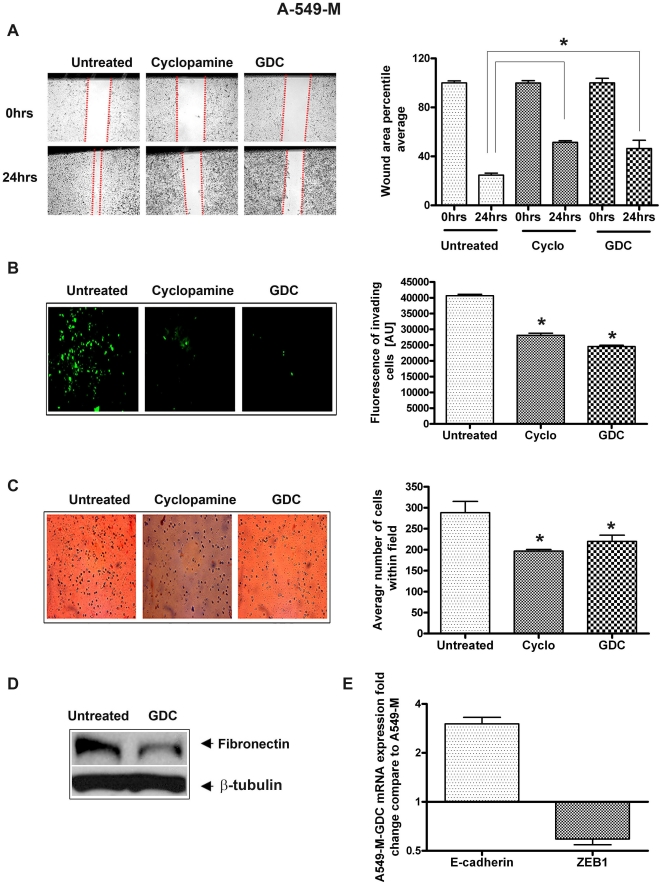
Up-regulation of Shh in A549-M cells contributes to increased tumor cells migration and metastatic characteristics:A549-M cells were treated with Shh inhibitors such as Cyclopamine (2 µM) and GDC-0449 (20 nM) and assayed for wound healing (A), invasion (B) and clonogenic growth (C), and performed quantitative analysis showing attenuation of invasion by the treatment with Shh inhibitors. Western blot of A549-M cells before and after treatment with GDC-0449 (20 nM) for the expression of fibronectin (D). qRT-PCR for the expression of E-cadherin and ZEB1 mRNA in A549-M cells after treatment with GDC-0449 (20 nM) showing reversal of EMT phenotype compared to untreated A549-M cells (E). (*  =  p<0.05).